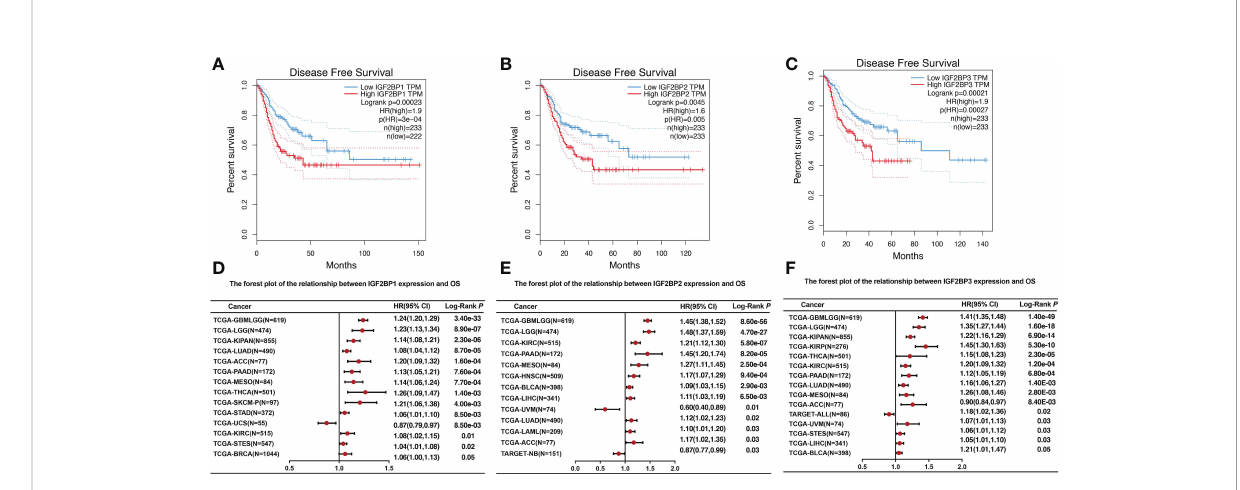
FIGURE 3 The relationship between IGF2BPs expression level and overall survival. (A-C) Kaplan – Meier survival curves comparing the high and low expression of IGF2BPs in 33 cancer types. (D) The forest plot of the relationship between IGF2BP1 expression and OS across 13 tumors. (E) The forest plot of the relationship between IGF2BP2 expression and OS across 12 tumors. (F) The forest plot of the relationship between IGF2BP3 expression and OS across 15 tumors.